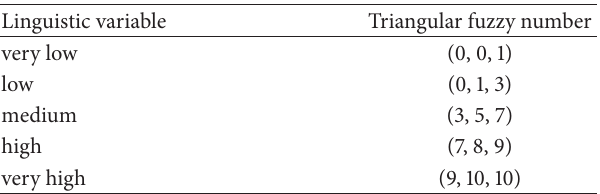
Table 4: Assignment of triangular fuzzy numbers to linguistic variables for rating simulated value of objectives.